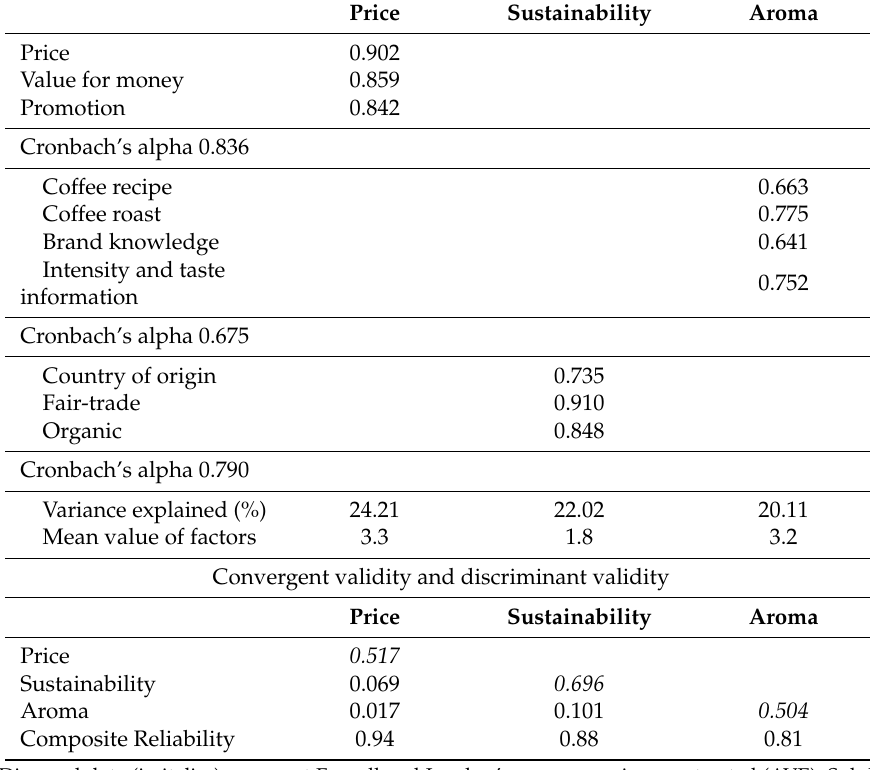
Table 6. Factor analysis on motives for coffee purchasing and convergent validity and discriminant validity for each